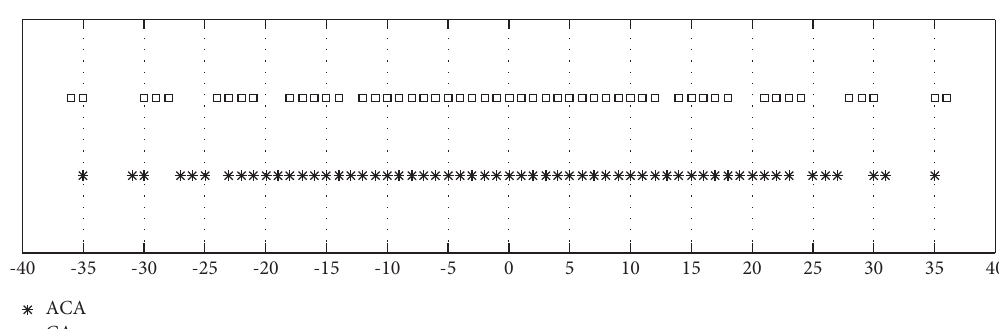
Figure 1: ACA structure.